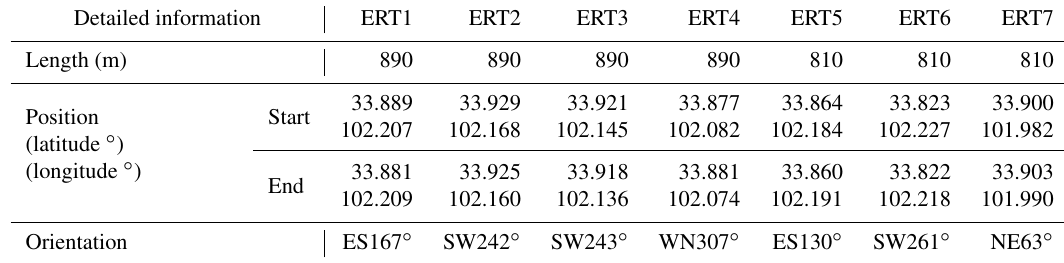
Table A4. Detailed information on ERT.